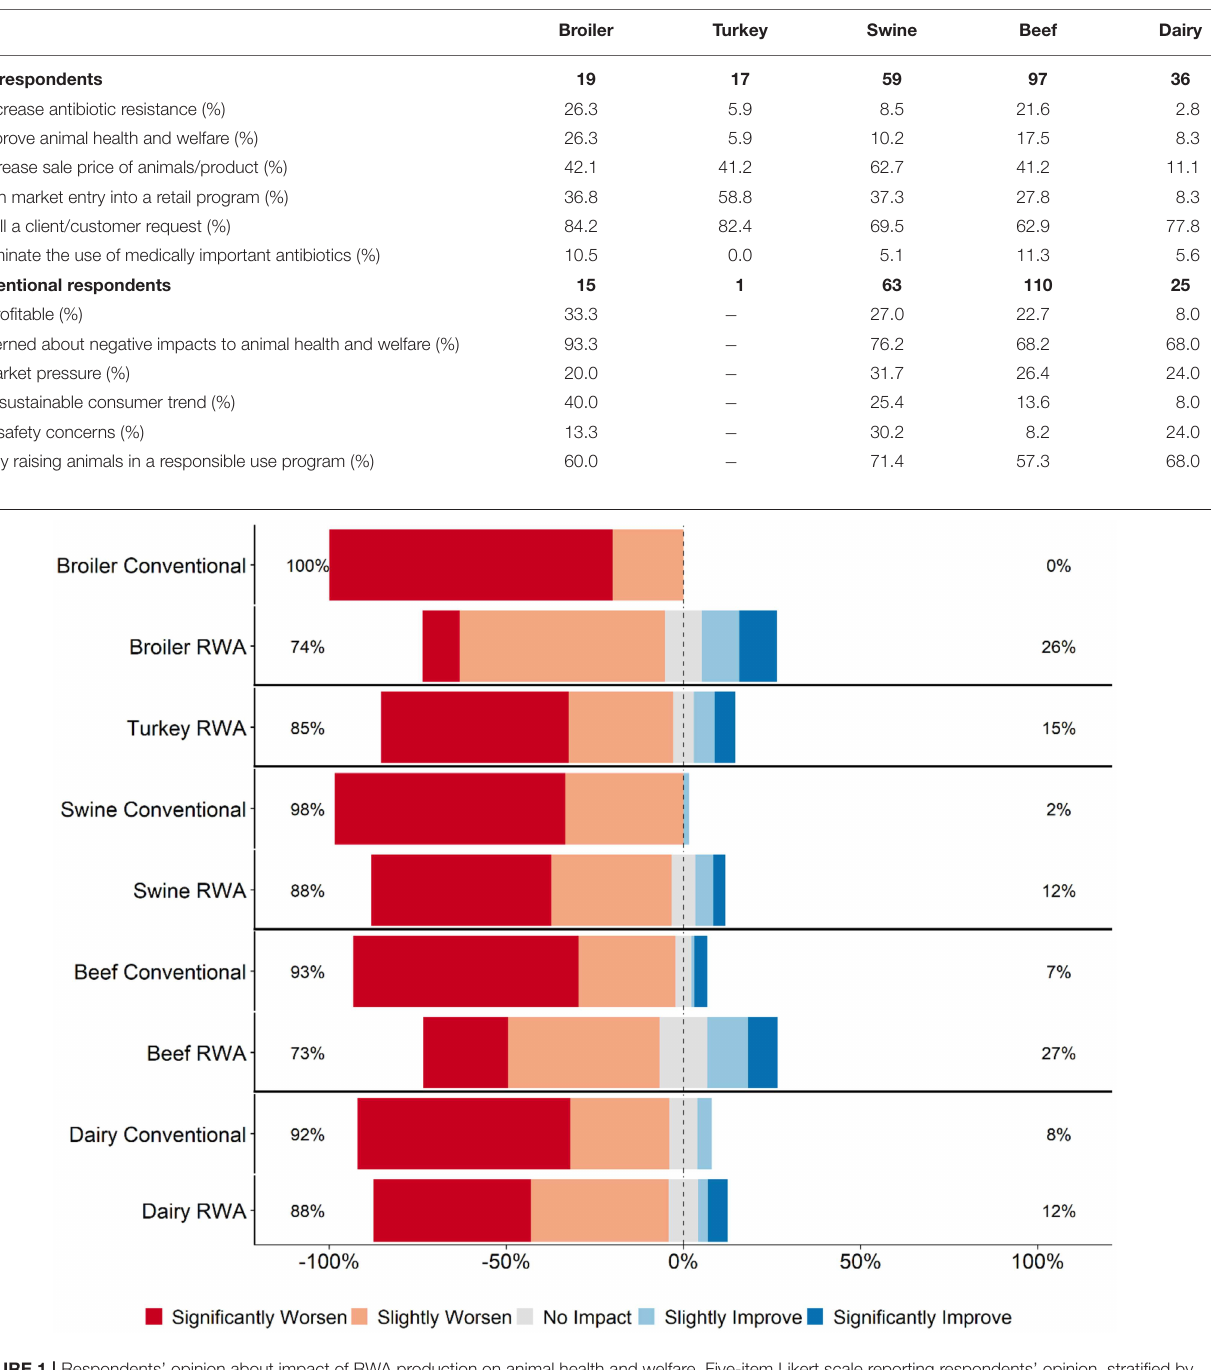
Frontiers in Veterinary Science |